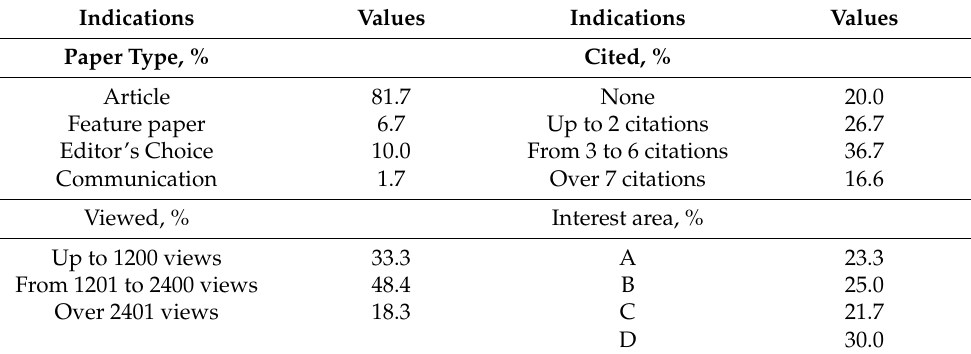
Table 1. Overall results produced by this Special Issue (*). Indications Values Indications Values Paper Type, % Cited, % Feature